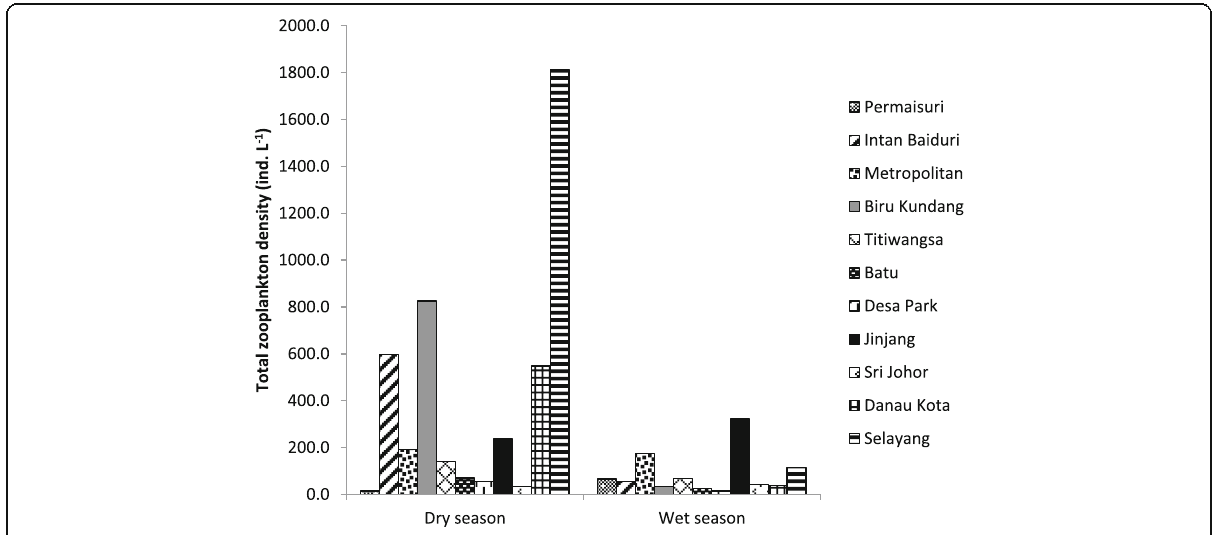
Fig. 4 Total zooplankton density during dry and wet seasons in studied lakes and